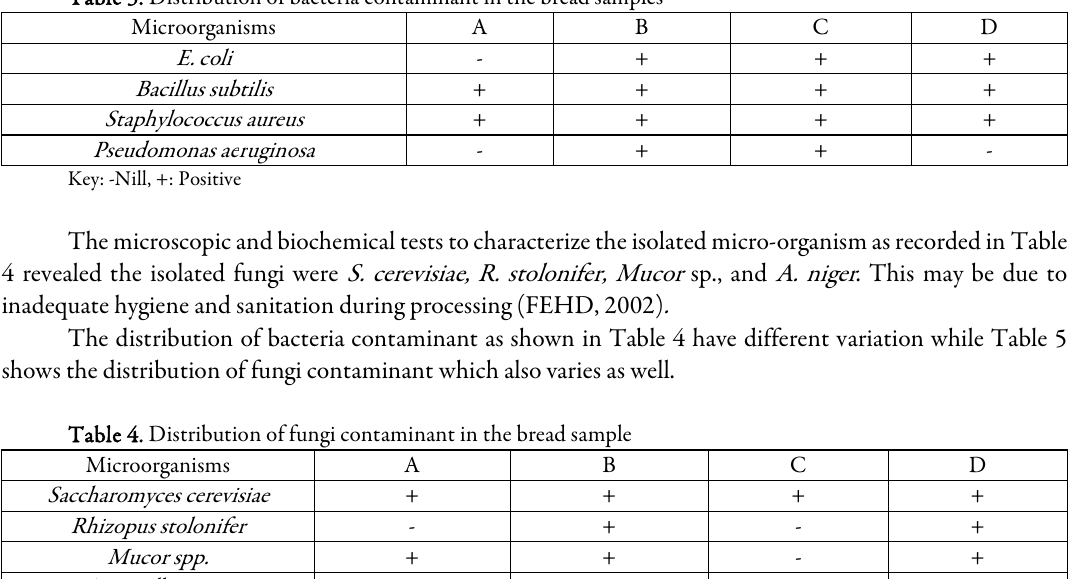
Table 4. Distribution of fungi contaminant in the bread sample Microorganisms A B C Saccharomyces cerevisiae - Mucor spp.